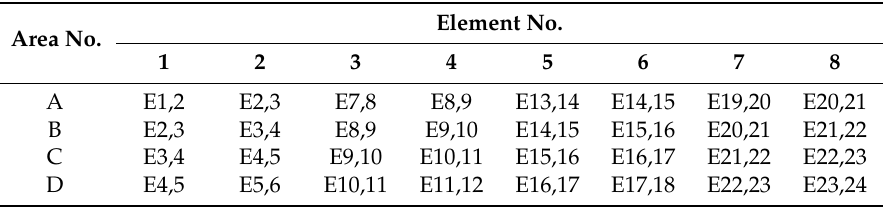
Table 4. Divided areas and the corresponding damaged elements.